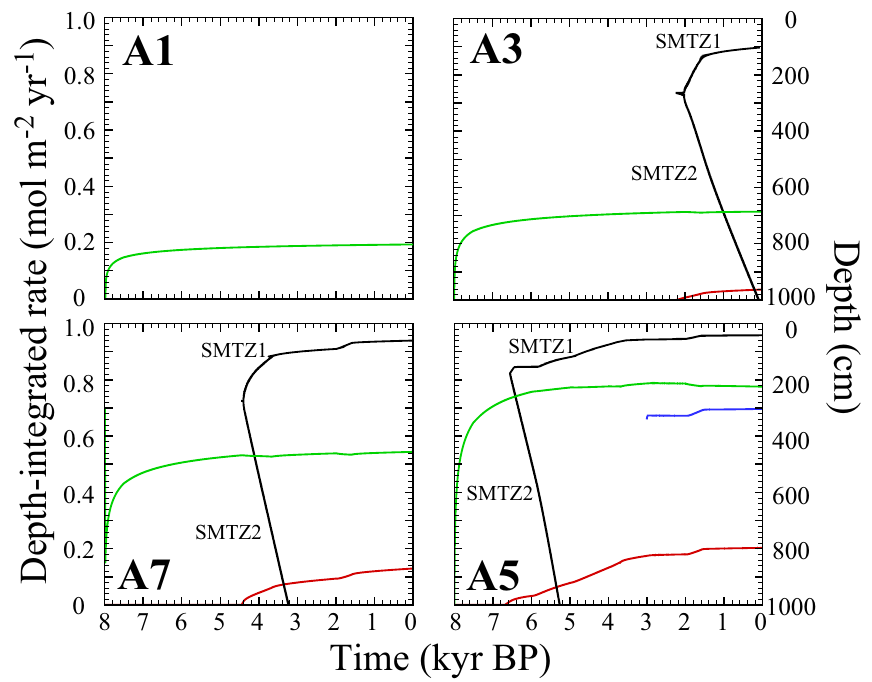
Fig. 9. Yearly-averaged temporal development (8kyrBP until present) of depth-integrated rates of sulphate reduction (green), AOM (red) and the SMTZ depth (black) at all stations. Concomitantly with the extension of the methanogenic zone, methane concentrations increase and methane diffuses increasingly closer to the sediment surface and the bottom of the Holocene organic rich mud creating two SMTZs where methane is consumed through AOM. At A5, the free gas depth (FGD) is indicated (blue). Note that the left y-axis governs the rates (green, red) while the right y-axis governs the depths (black,